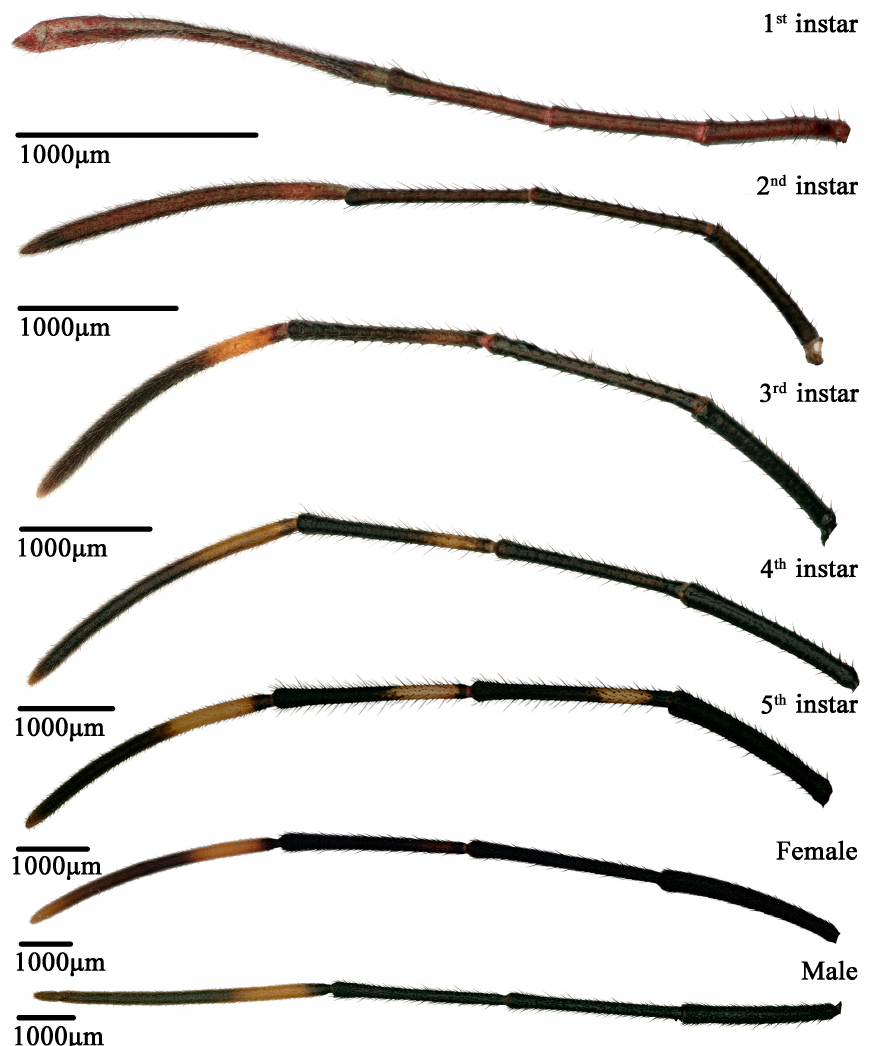
Figure 3. Morphological characteristics of N. meleagris antennae at each nymphal instar and adult. Insects 2023 , 14 , x FOR PEER REVIEW